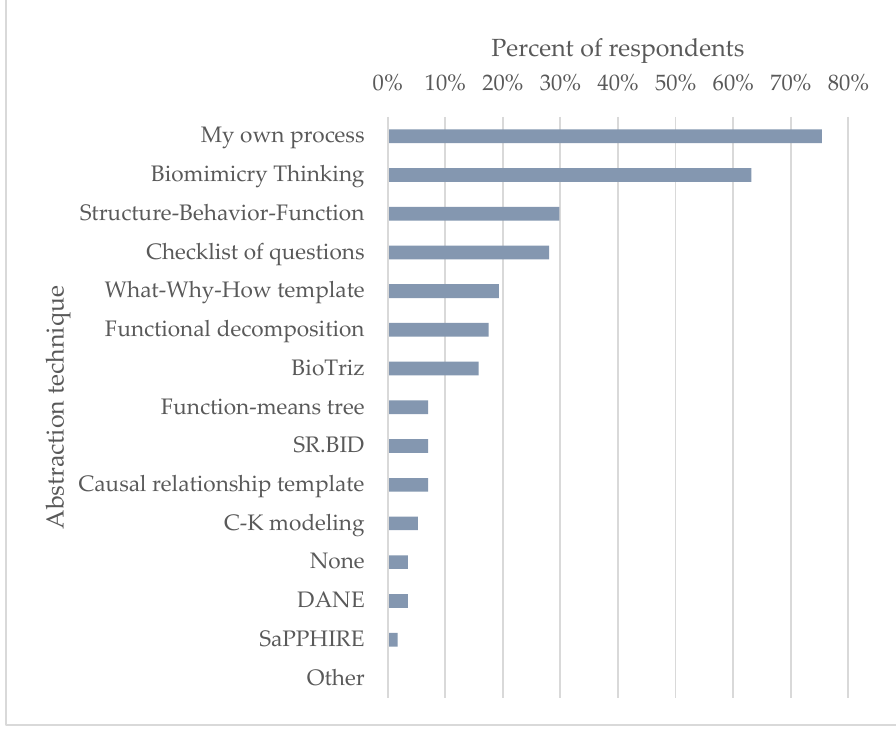
Figure 8. Use of abstraction techniques among survey respondents using physical models .